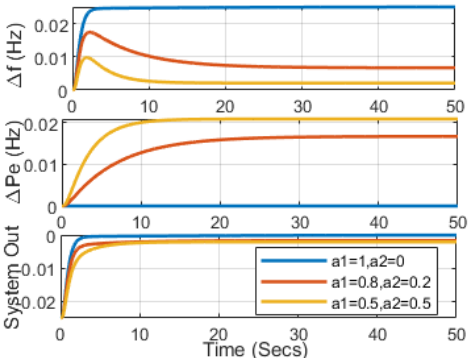
Figure 6. A comparison of the generator’s and EVs’ power output.